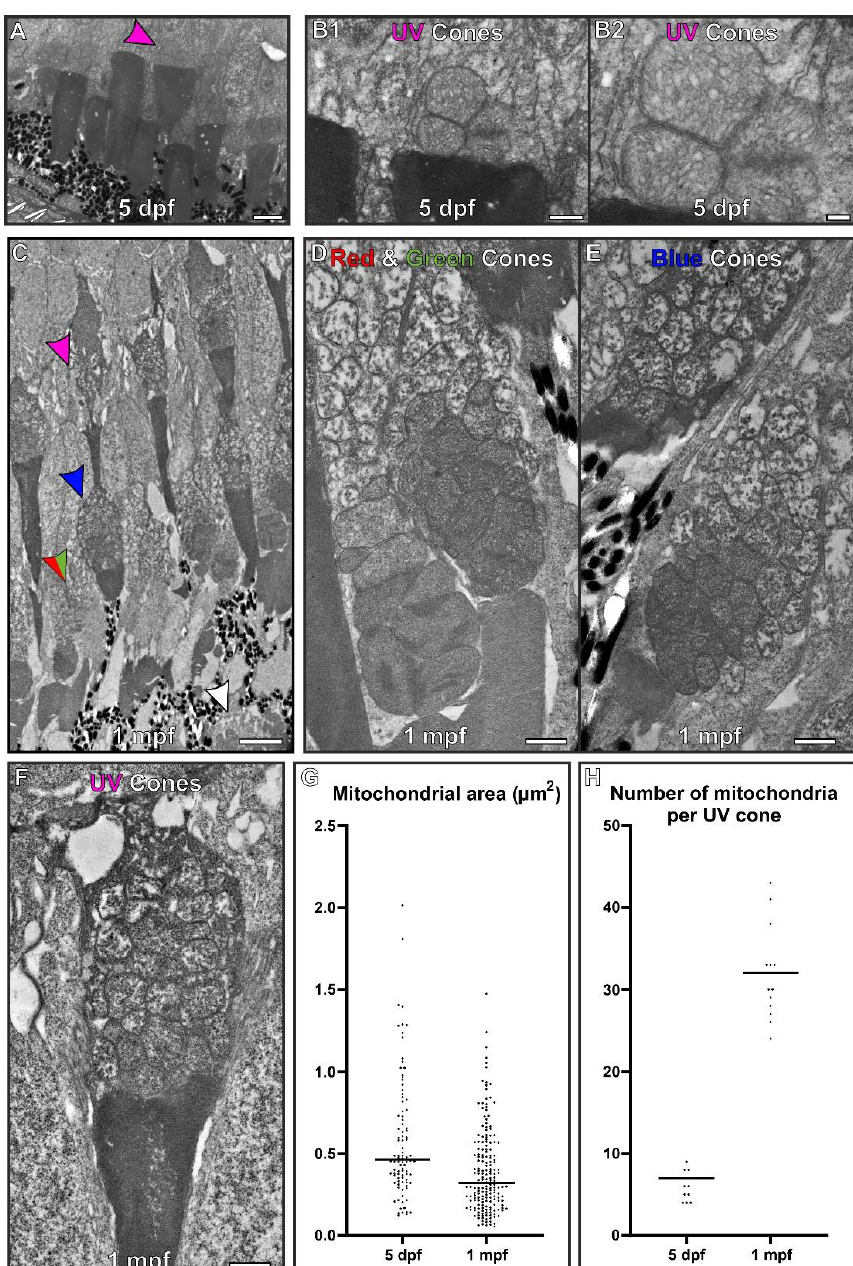
Figure 3. At 5 dpf, the mitochondria within cone inner segments have a morphology that is distinct from those found within 1 month old zebrafish. ( A ) At 5 dpf, the retina is still developing and it is difficult to distinguish between cone types. UV cones (purple arrowhead) were identifiable due to being positioned furthest from the RPE cell layer. ( B ) Higher magnification images of UV cone con- taining packed mitochondria. ( C ) By 1 mpf, the retina has fully formed and the different photore- ceptors can be readily identified. The arrows highlight the inner segment from different photore- ceptors: red and green arrows for red and green cones, blue arrows for blue cones, purple arrows for the UV cones and white arrowz for rod photoreceptors. ( D – F ) The corresponding cone types at 1 mpf are shown at higher magnification. ( G ) Mitochondria were found to reduce in size and ( H ) increase in number from 5 dpf to 1 mpf. Measurements were taken from n=3 zebrafish and included ( G ) >93 mitochondria and ( H ) n = 15 UV cones. Statistical significance was determined as ( G ) p < 0.001 by Mann – Whitney test (non-parametric based on Kolmogorov – Smirnov test) and ( H ) p < 0.001 by unpaired t-test. Scale ( A , C ) 5 µm, ( B , D – F ) 1 µm.